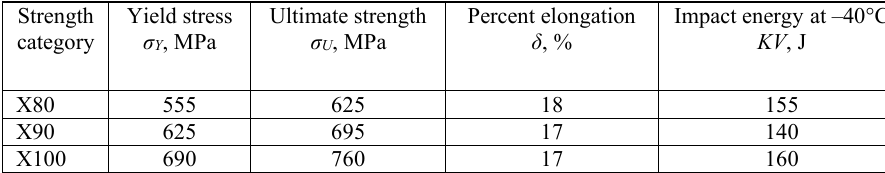
Table 1. Mechanical properties of pipe